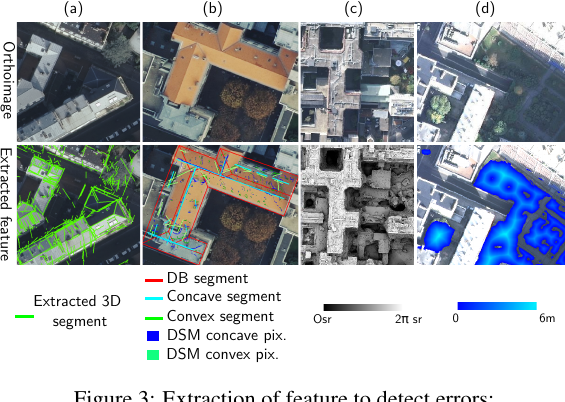
Figure 3: Extraction of feature to detect errors: a- Image based 3D segment extraction ( Σ img ), b- Mixed DSM-image based 3D segment extraction ( Σ mix ), c- Sky Viewshed Angle (SVA), d- Distance based NDVI mask (D NDVI ).